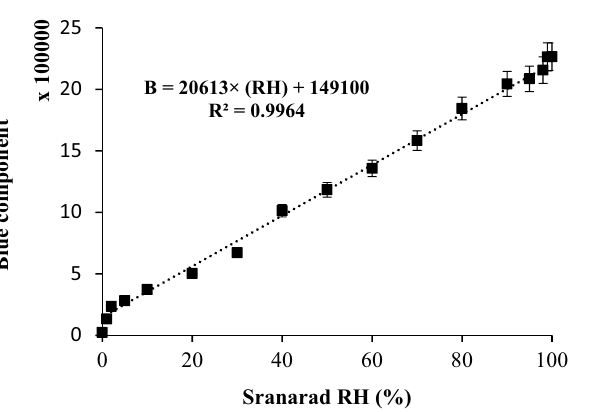
Figure 9. Calibration curve of RGB parameter vs. %RH. Conditions: standard RH: 0–100%, applied voltages: 110 ± 1 V (AC, vs. GND), pressure: 25–30 torr, and temperature 40–45 °C. The data are the average of three independent analyses at optimum conditions. Error bar: ± relative standard